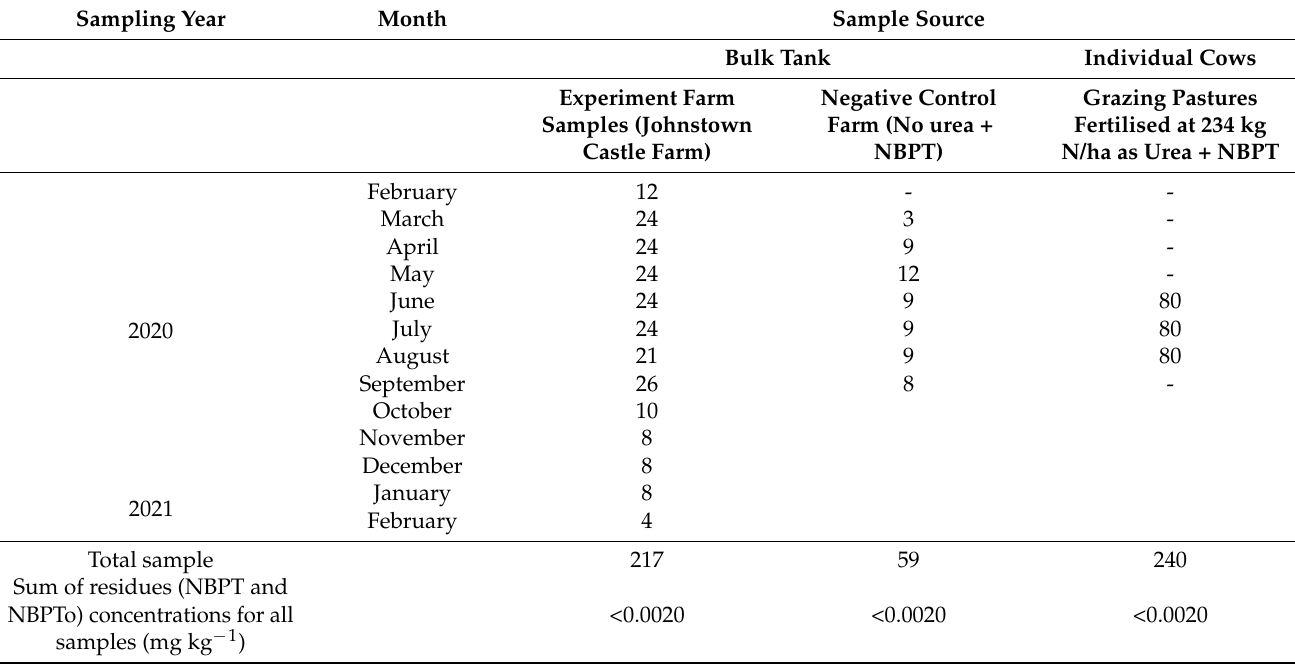
Table 2. Sampling periods and summary result of NBPT and NBPTo residues in milk sampled on a farm using NBPT treated urea (NBPT Farm) and a farm not using NBPT treated urea (control